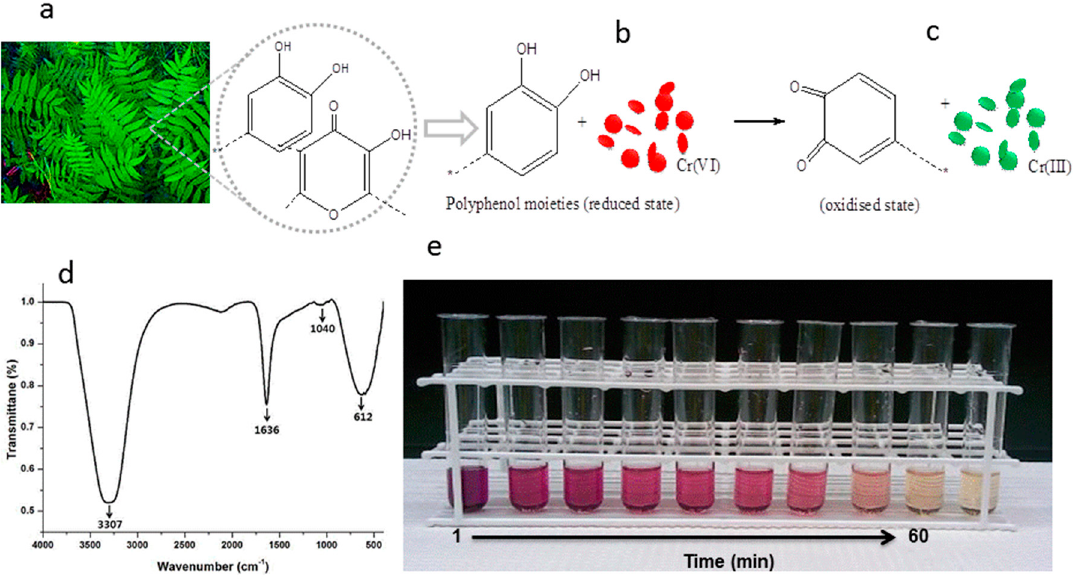
Figure 8. ( a – c ): Schematics describing reduction mechanism of Cr(VI) using polyphenols and flavonoids; ( d ) Fourier Transform Infrared Spectroscopy (FTIR) spectra of native PLE sample; and ( e ) Gradual conversion of carcinogenic Cr(VI) into nontoxic Cr(III).